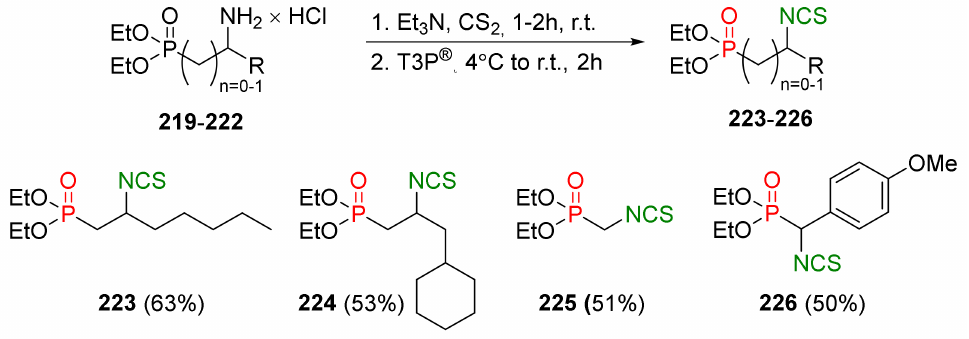
Figure 35. Synthesis of α - and β -dialkoxyphosphoryl isothiocyanates 223 – 226 . A series of diaryl (1-isothiocyanoalkyl)phosphonates 237 – 246 were prepared and tested for inhibition of human tumor proliferation by Oleksyszyn and co-workers